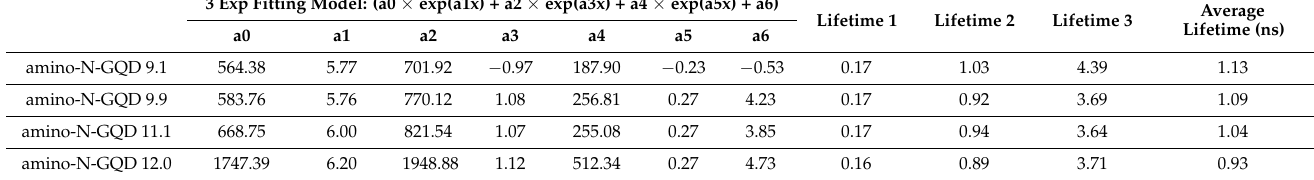
Table 3. Lifetime data and parameter generated using a time-correlated single-photon counting technique involving a triple-exponential fitting function while monitoring the emission under TPE. Delivered dose: 0.75 µ g mL − 1